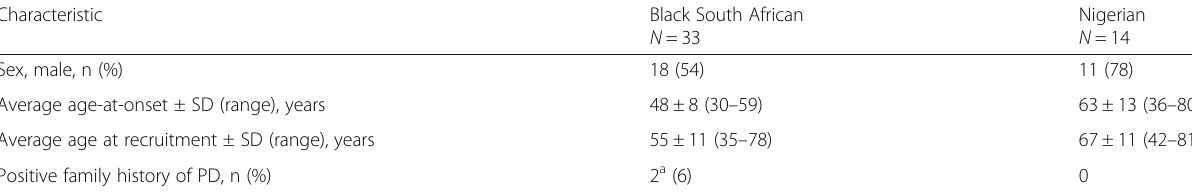
Table 1 Characteristics of the 47 Parkinson ’ s disease patients